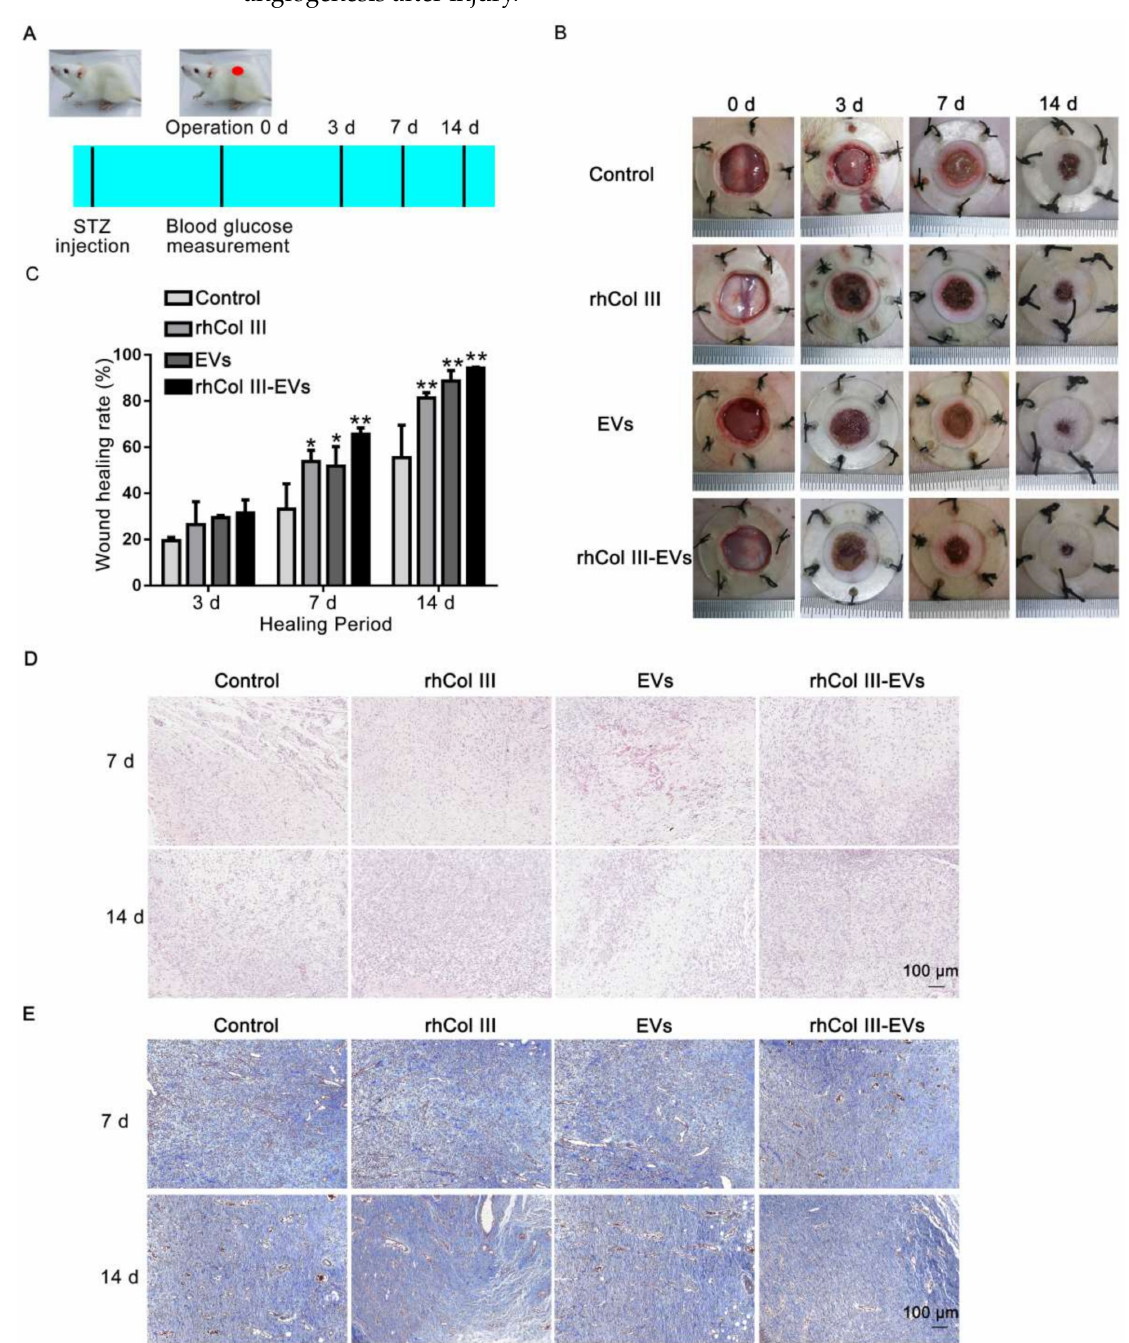
Figure 5. The effect of experimental group on wound healing in vivo. ( A ) Schematic diagram of diabetic rat wound model. ( B ) Representative wound images from each group at 0, 3, 7 and 14 days. ( C ) Wound healing rate of each group at different times ( n = 3, * p -value < 0.05 vs. Control group, ** p -value < 0.01 vs. Control group). ( D ) HE analysis of wound tissue in each group at 7 and 14 days. ( E ) Masson analysis of wound tissue in each group at 7 and 14